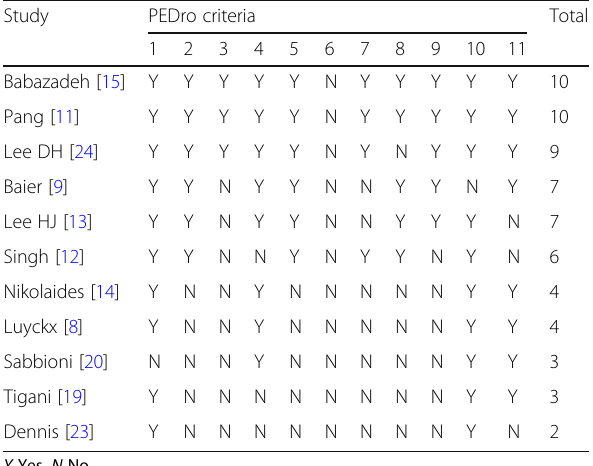
Table 2 PEDro critical appraisal score